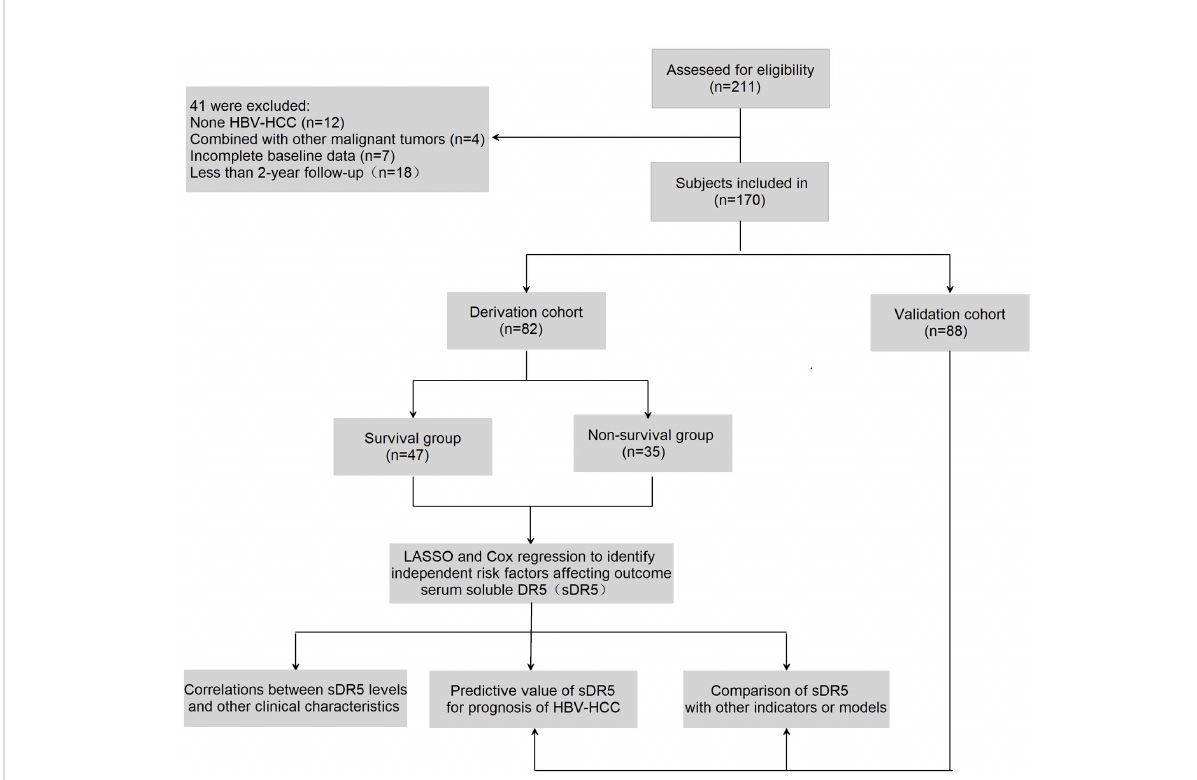
FIGURE 1 Flow chart of the clinical research. A total of 211 subjects were screened for eligibility, 170 patients were included in the research. Among them, 82 participants were selected in the derivation group and 88 in validation